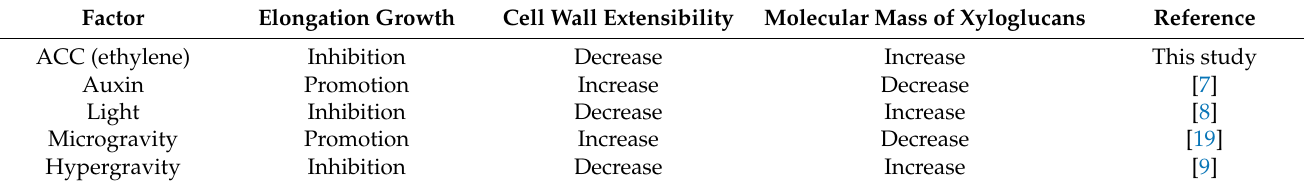
Table 1. Relationship between elongation growth, cell wall extensibility, and molecular mass of